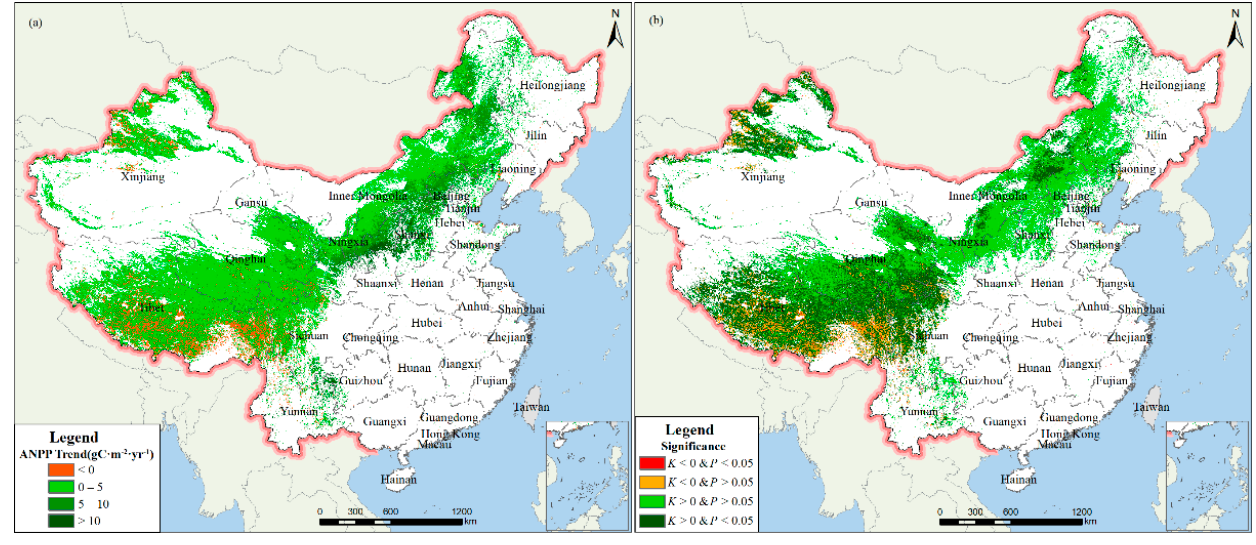
Figure 7. ( a ) Trend in ANPP (2001–2020) and ( b ) the significance levels. (Note: K is the change trend of ANPP, and P is the significance levels).